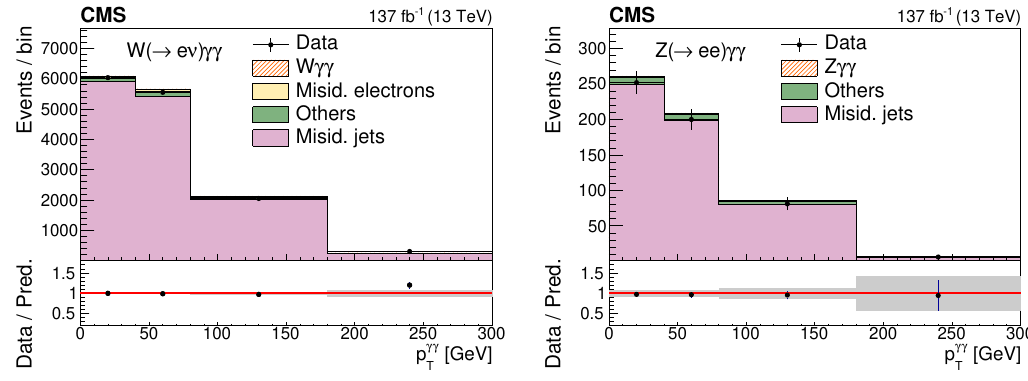
Figure 3 . Distribution of the transverse momentum of the diphoton system, obtained in the control region enriched in jets misidentified as photons, for the W gg and for the Z gg electron channels. The black points represent the data with error bars showing the statistical uncertainties. The hatched histogram shows the expected negligible signal contribution. The background estimate for electron (jet) misidentified as photons, obtained from control samples in data, is shown in yellow (purple). The remaining backgrounds, derived from MC simulation, are shown in green. In the ratio plots, the grey hashed area is the statistical uncertainty on the sum of signal and backgrounds, while the uncertainty in the black dots is the statistical uncertainty of the